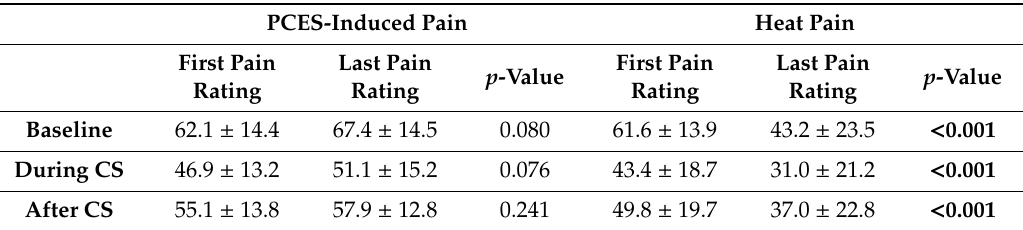
Bold: p -value below the level of